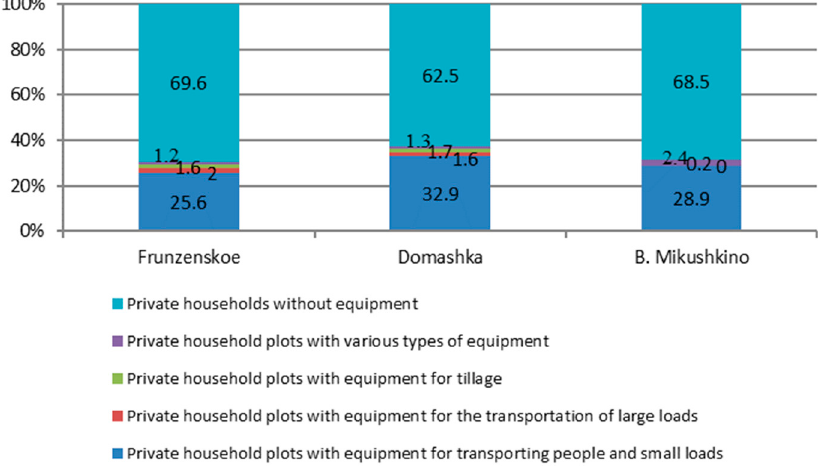
Figure 14. Comparison of private household plots by equipment.